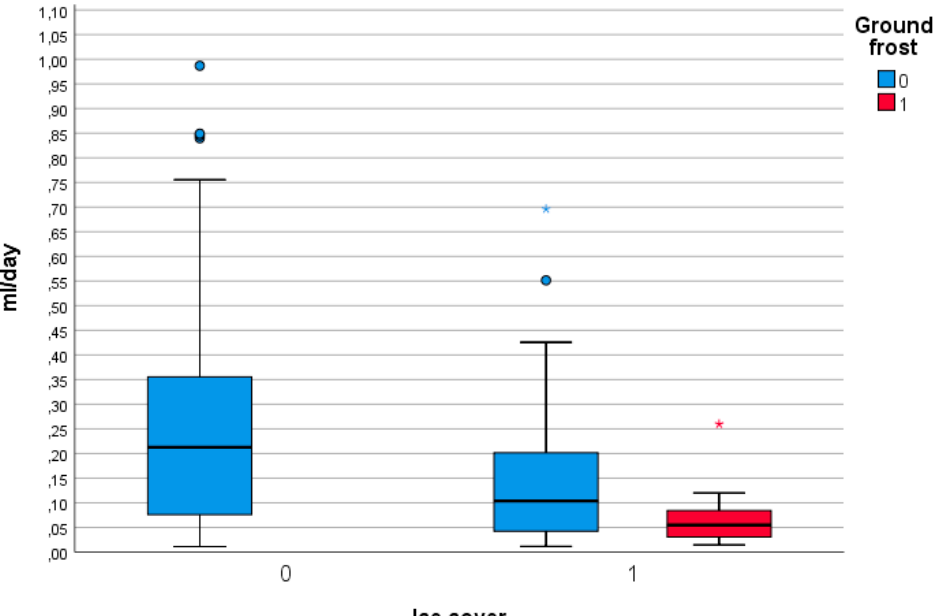
Figure 8. Boxplot of sediment flux rate with ice cover and ground frost grouping variables. Group value 0 means no ice cover and 1 means the presence of ice cover; for ground frost, group value 0 means no ground frost and 1 means the presence of ground frost at least in 1 cm deep. Note that the ground frost group value 1 boxplot is missing ice cover group 0, because there were no data for this group. Points represent outliers and asterisks represent extreme outliers.